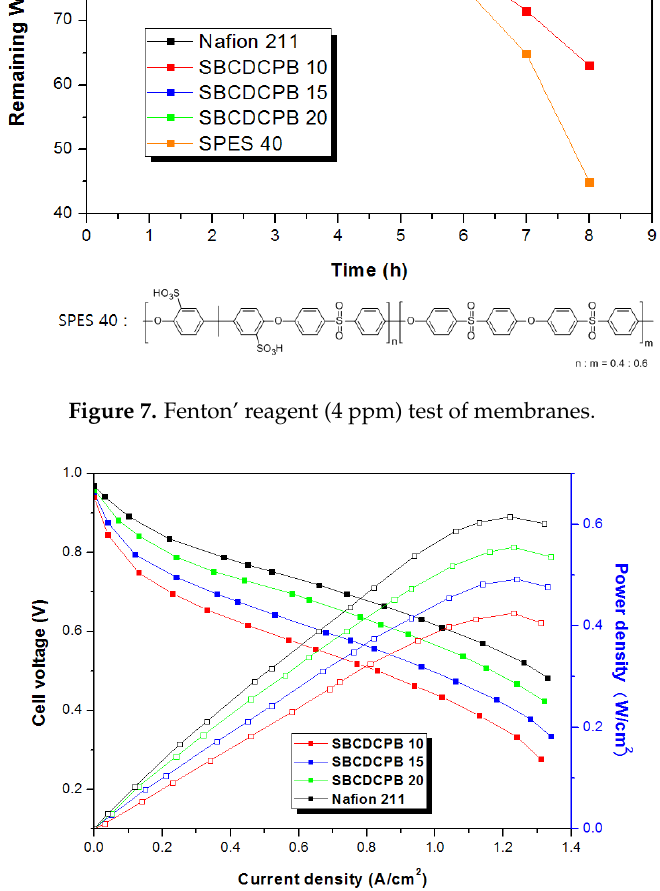
Figure 8. Cell test of sulfonated membranes.